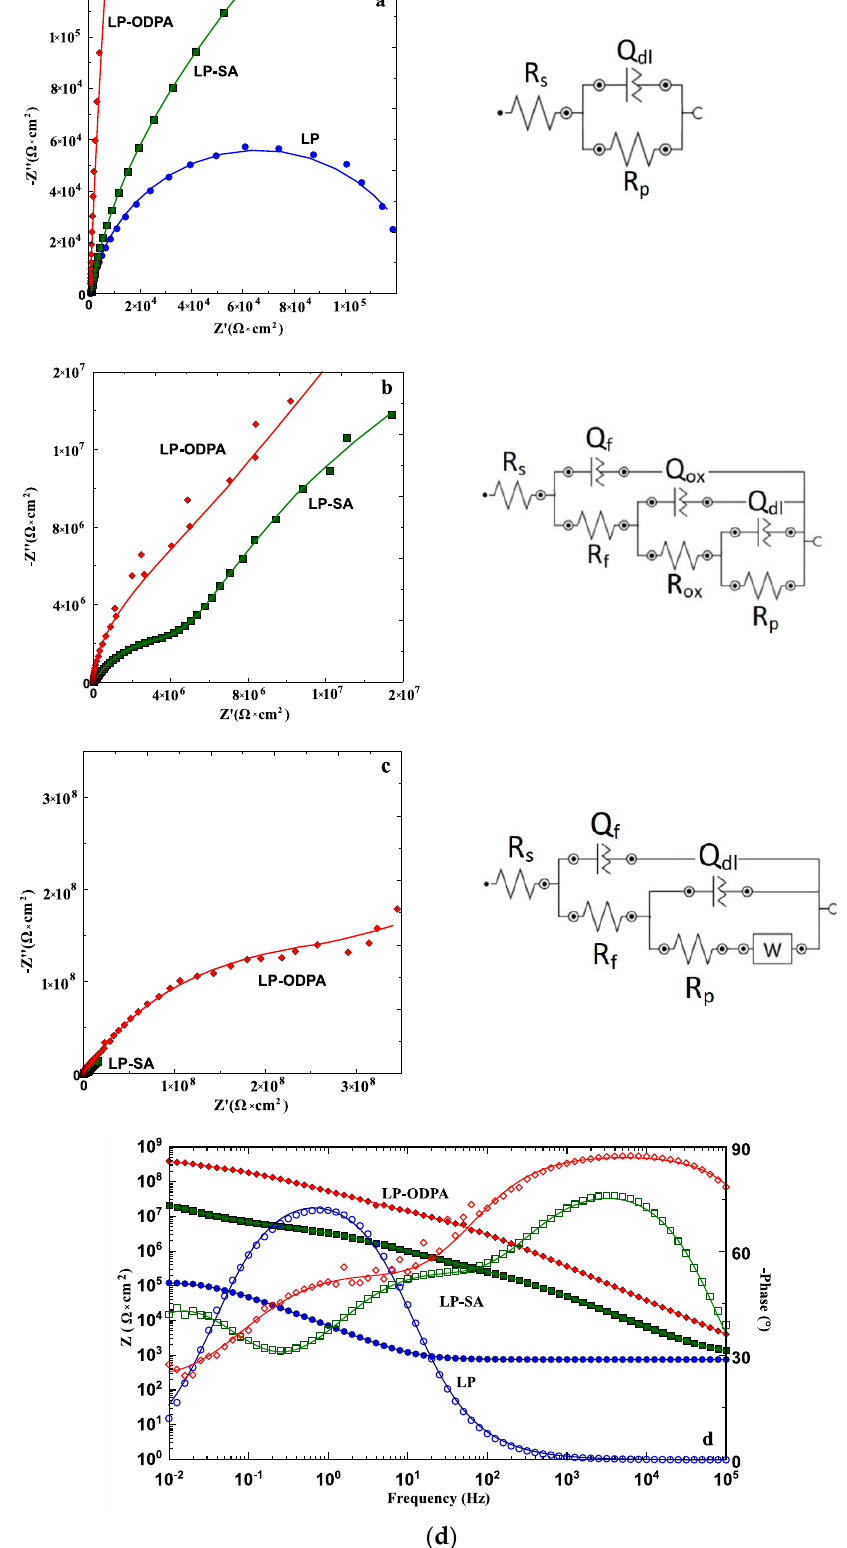
Figure 4. Nyquist ( a – c ) and Bode ( d ) diagrams obtained in a borate buffer solution on alloy 6063 after LP, as well as after LP and subsequent treatment with SA and ODPA.